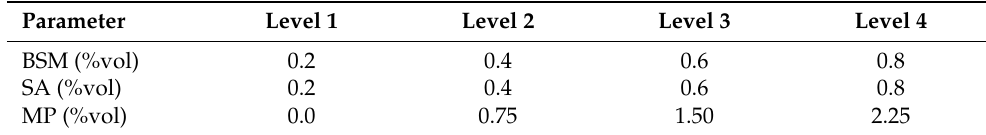
Table 4. Factors and their levels.